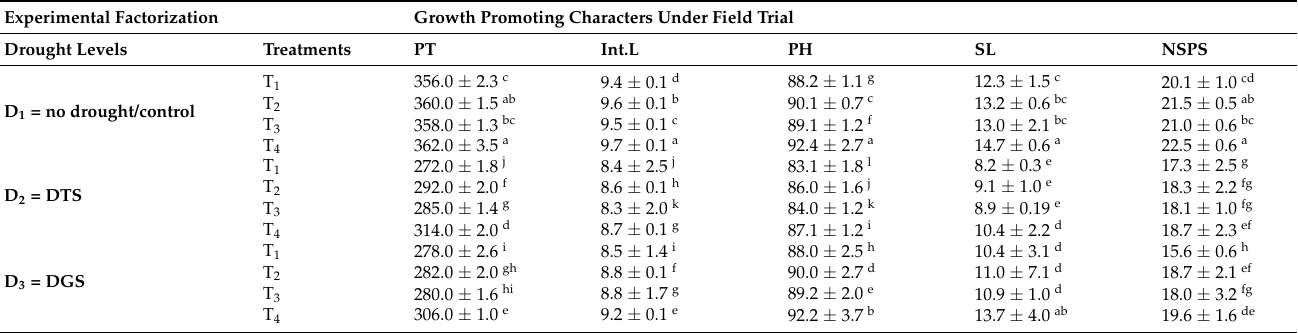
Table 1. Effects of applying Azospirillum brasilense and zinc oxide nanoparticles on wheat resilience to drought at different growth